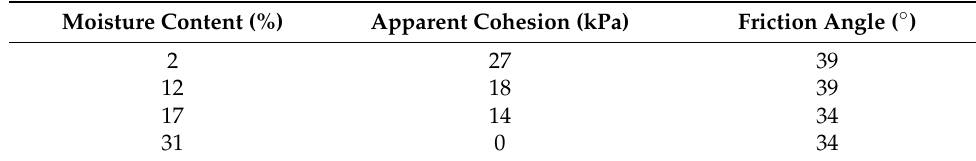
Figure 1. Shear box apparatus: ( a ) shear box apparatus and data log; ( b ) 60 mm × 60 mm shear box. Table 1. Shear box test results.